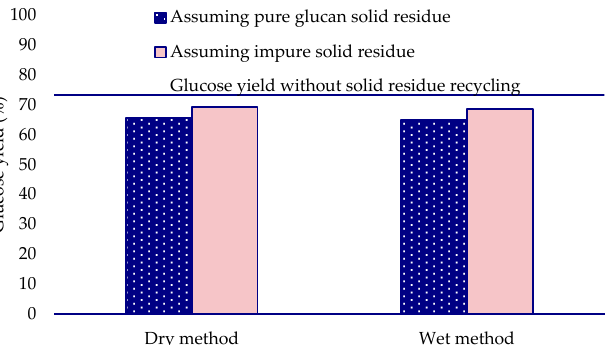
Figure 5. Glucose yield after acid hydrolysis of cotton waste textiles combined with the solid residue from a previous treatment cycle. The two values of the yield were calculated assuming that the solid residue contained non-cellulosic impurities (pink) or not (blue with white dots).